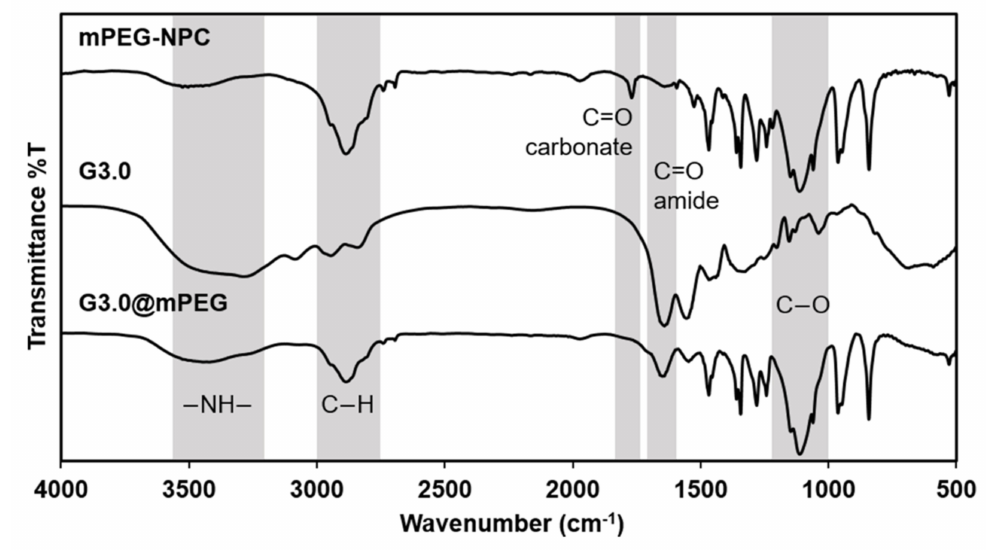
Figure 2. FT-IR spectra of mPEG-NPC, G3.0 and